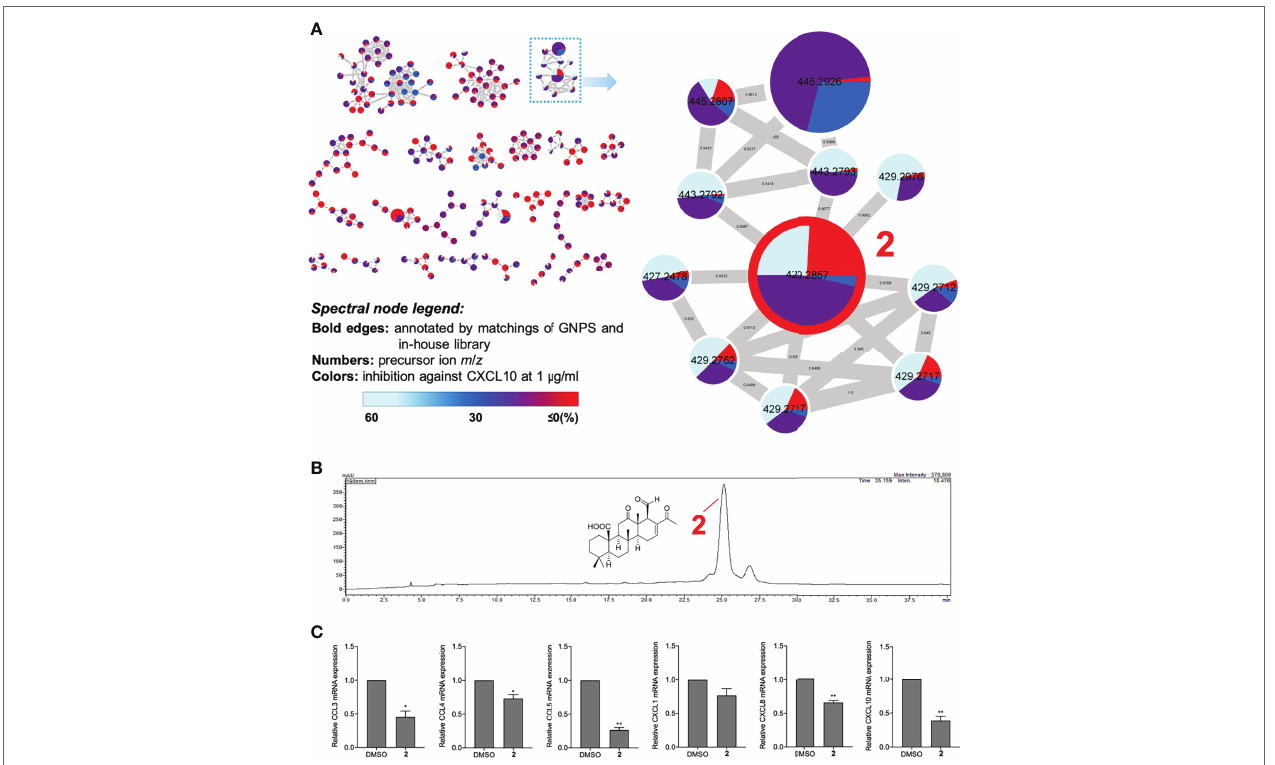
FIGURE 5 | The visualized MIMN revealed the most potent anti-chemokine scalarane, 24-methyl-12,24,25-trioxoscalar-16-en-22-oic acid (2). (A) The MIMN was established according to the inhibition of CXCL10 expression (1 μg/ml) in CRL-3390 cells. (B) The isocratic HPLC-PDA chromatogram of BRW7 at 190 nm. (C) The assessment of chemokine inhibition (1 μM). Results are presented as mean ± S.E.M. (n = 3). * p < 0.05, ** p < 0.01 compared with the control